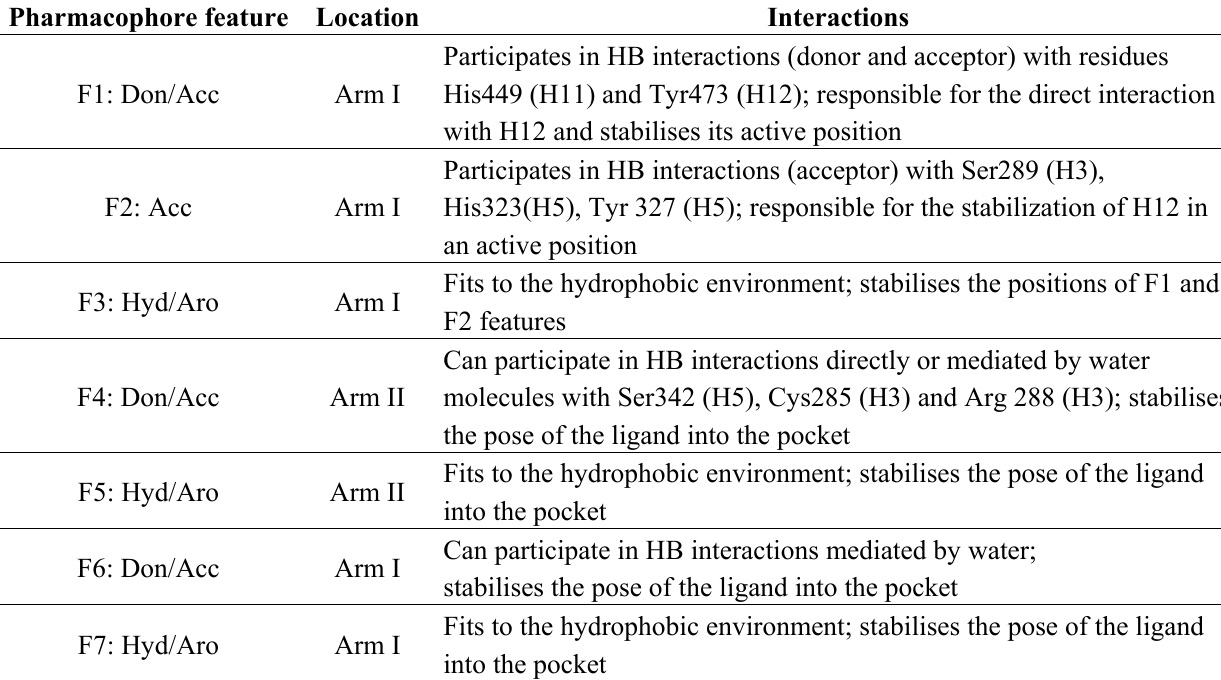
Table 1. Description of the pharmacophore features in the pharmacophore model of the full PPAR γ agonists. Don, donor; Acc, acceptor; Hyd, hydrophobic; Aro,